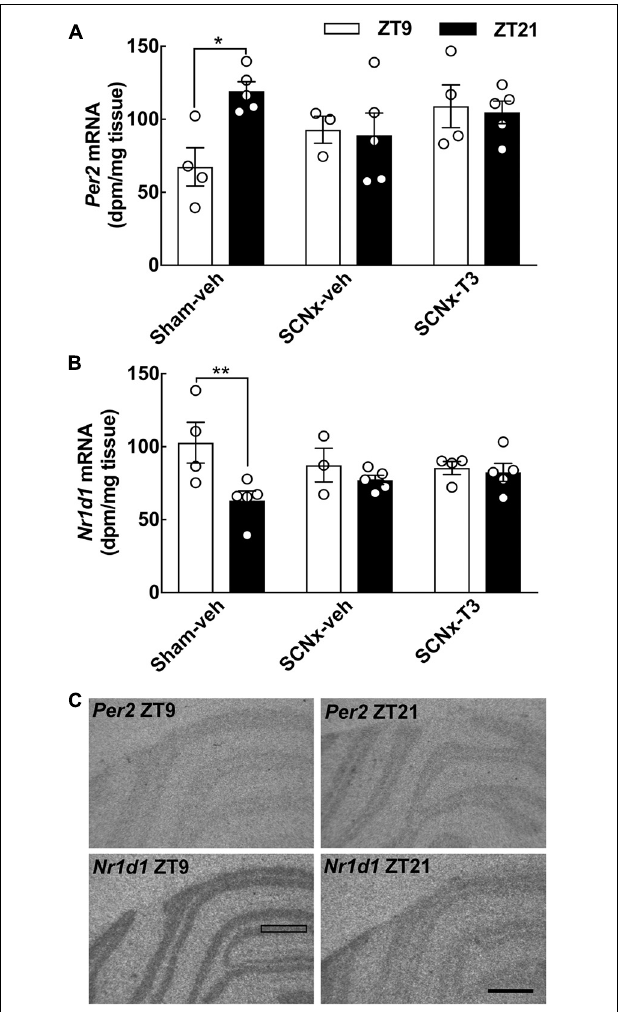
FIGURE 6 | Effects of circadian oscillating T3 concentrations on clock gene expression determined by in situ hybridization. Radiochemical in situ hybridization for detection of the clock gene-encoded transcripts Per2 (A) and Nr1d1 (B) transcripts in the cerebellum of three experimental groups of adult rats (8 weeks of age), Sham-veh, SCNx-veh, and SCNx-T3, at ZT9, and ZT21, respectively. Representative autoradiographs are displayed (C) . The rectangle indicates an area of the cerebellar cortex used for quantification. Scale bar, 1 mm. Quantitative data were analyzed by two-way ANOVA followed by Bonferroni multiple-comparisons tests. Day-night differences were detected in Sham-veh animals. Significance levels of Bonferroni multiple-comparisons tests are displayed. * p < 0.05; ** p < 0.01. n =